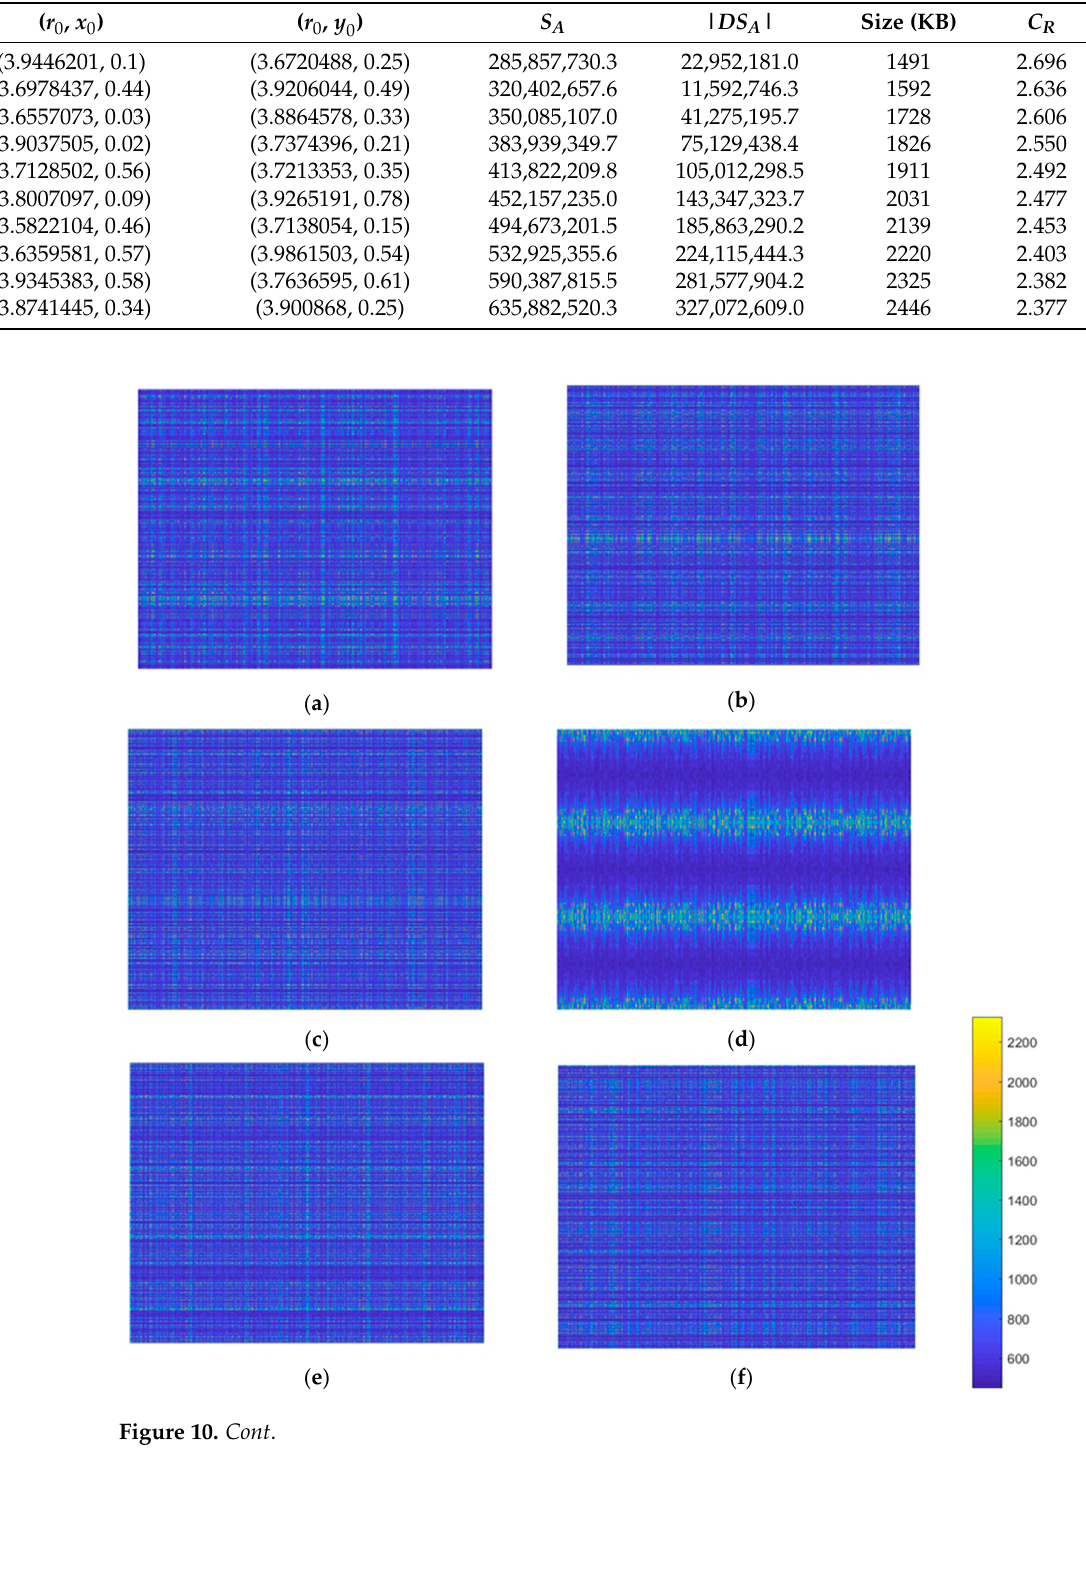
Table 5. The best key pairs among 10 encryption rounds for DEM B.